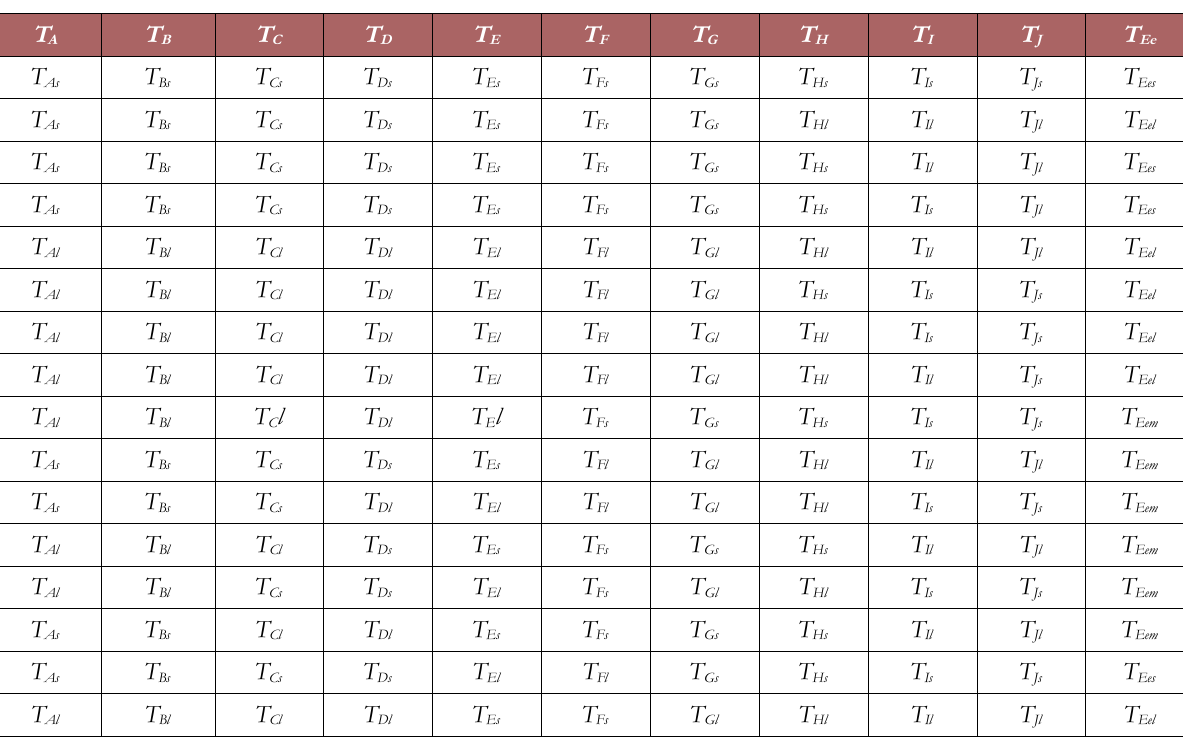
Table 18. Linguistic statements of the fuzzy logic model